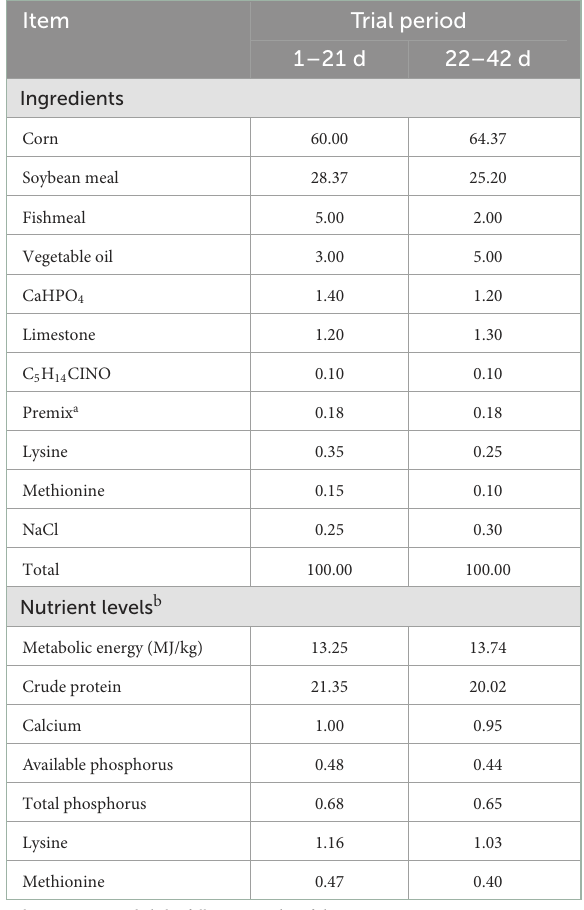
TABLE 1 Composition and nutrient levels of the basal diet (air-dry basis,